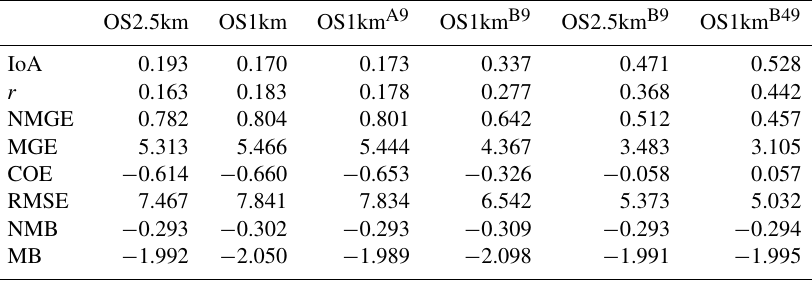
Table B8. Surface PM 2 . 5 observations to model comparison, nighttime (18:00–09:00LT) (µgm − 3 , 1862 model–observation